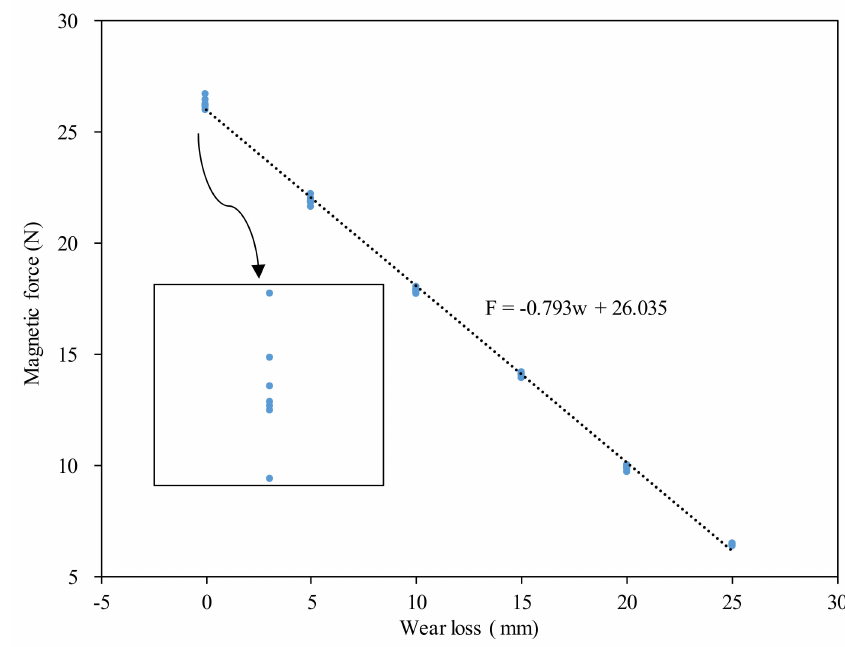
Figure 10. Experimental test results of cutter wear